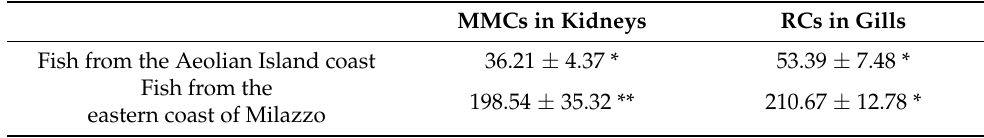
Table 5. Statistical analysis of MMCs in kidneys and RCs in gills of Boops boops . Fish from the Aeolian Island coast